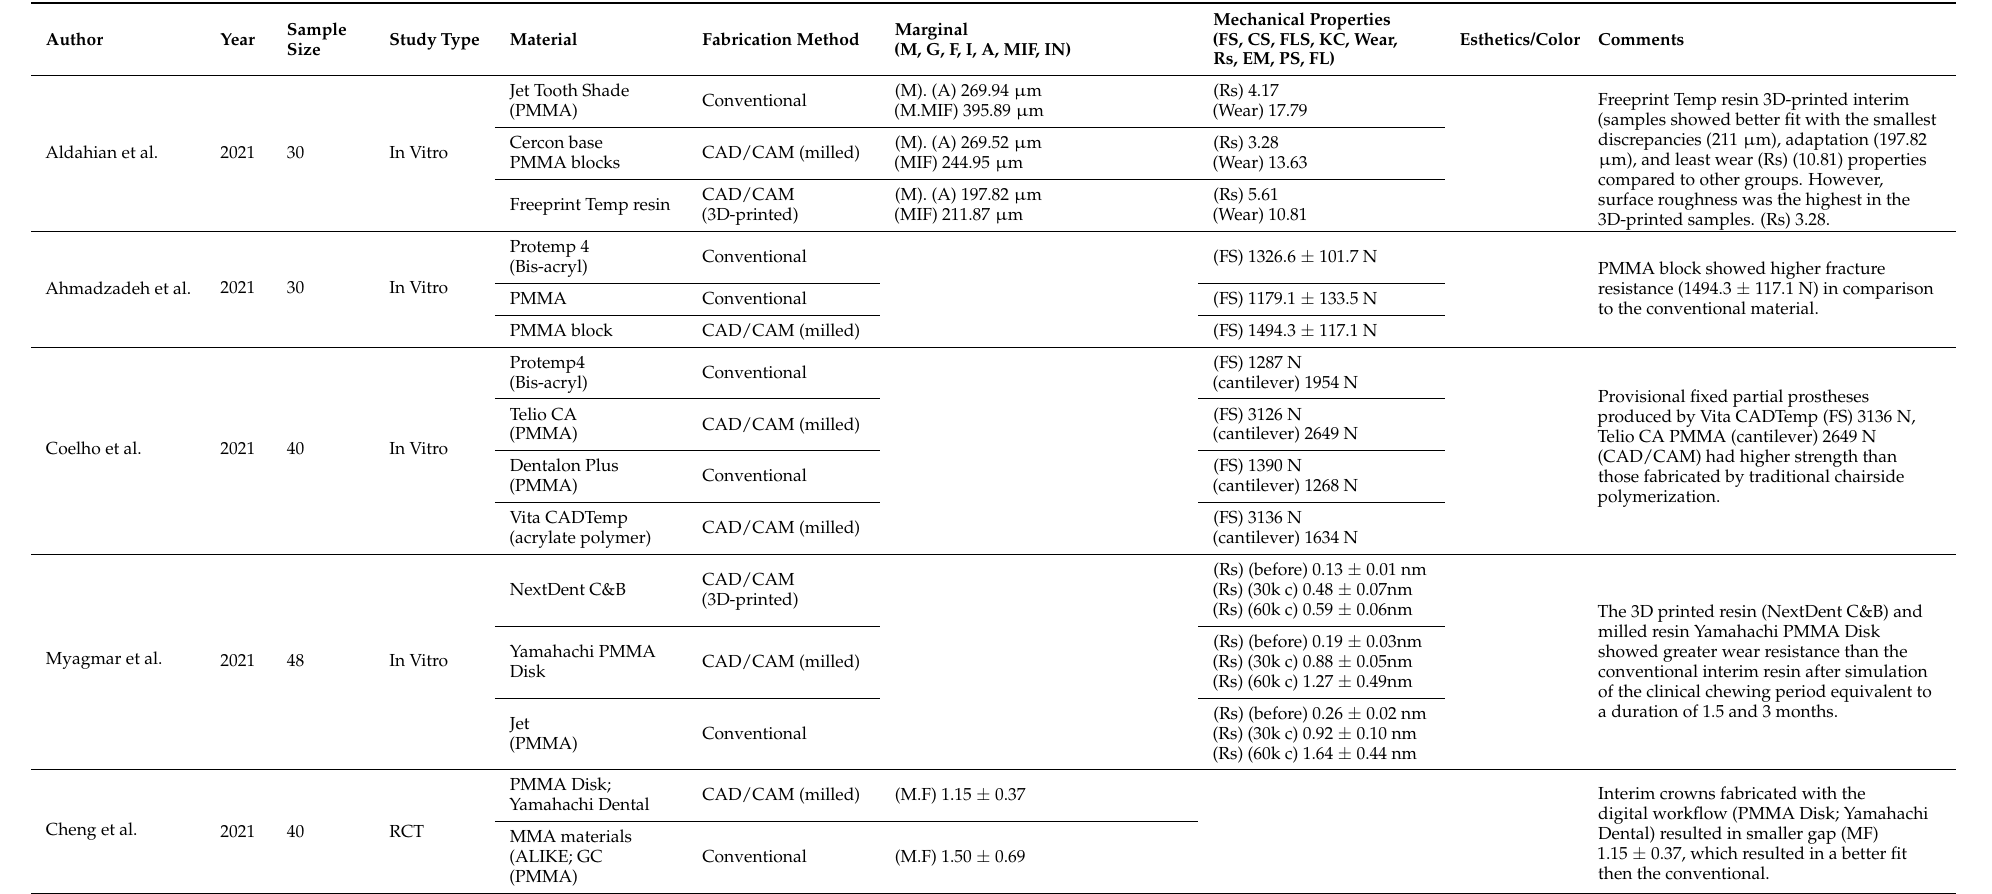
Table 4. Summarized results of 19 included